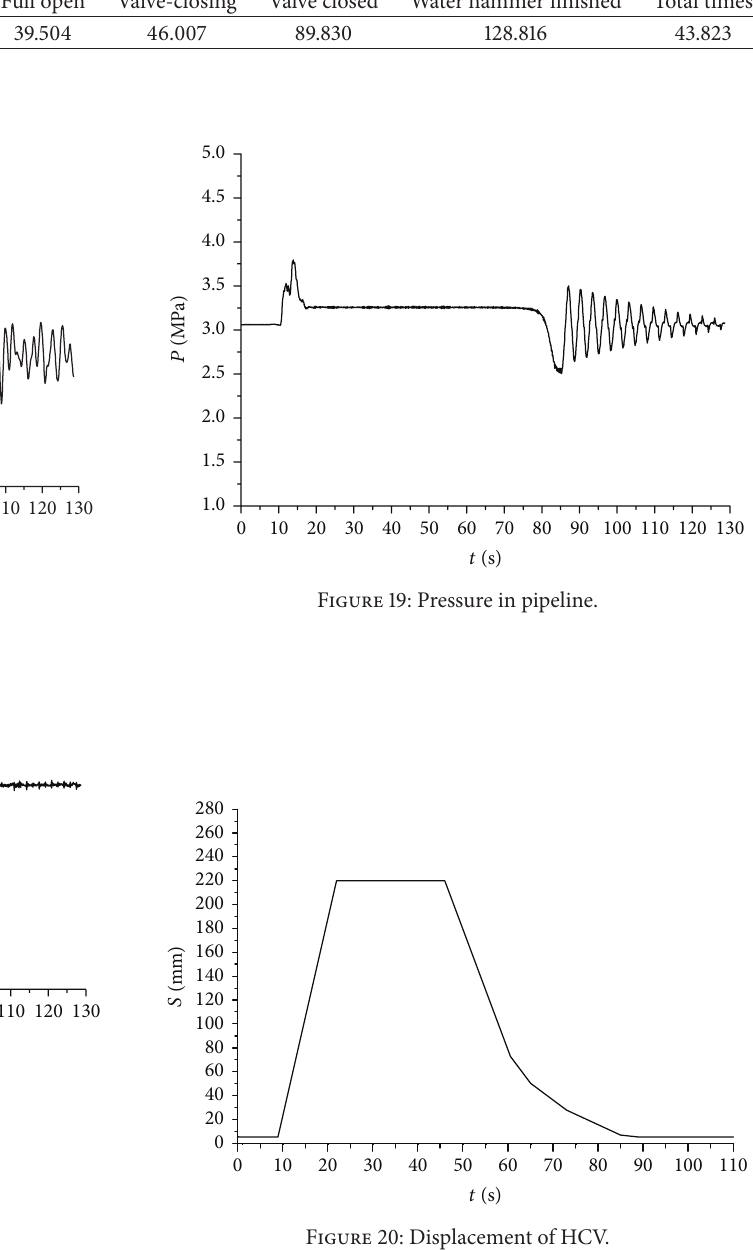
Figure 20: Displacement of